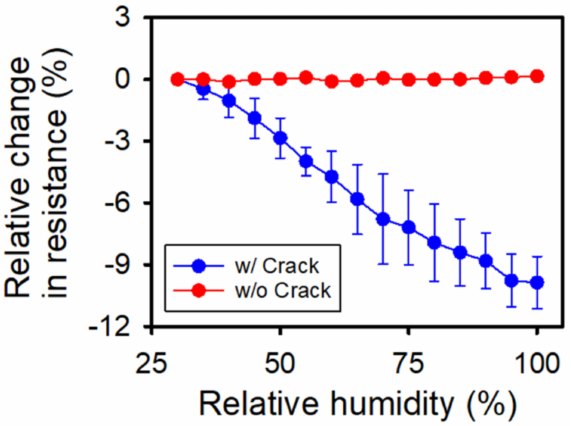
Figure 2. Relative changes in resistance due to the relative humidity for sensors without (red) and with (blue) crack formation.